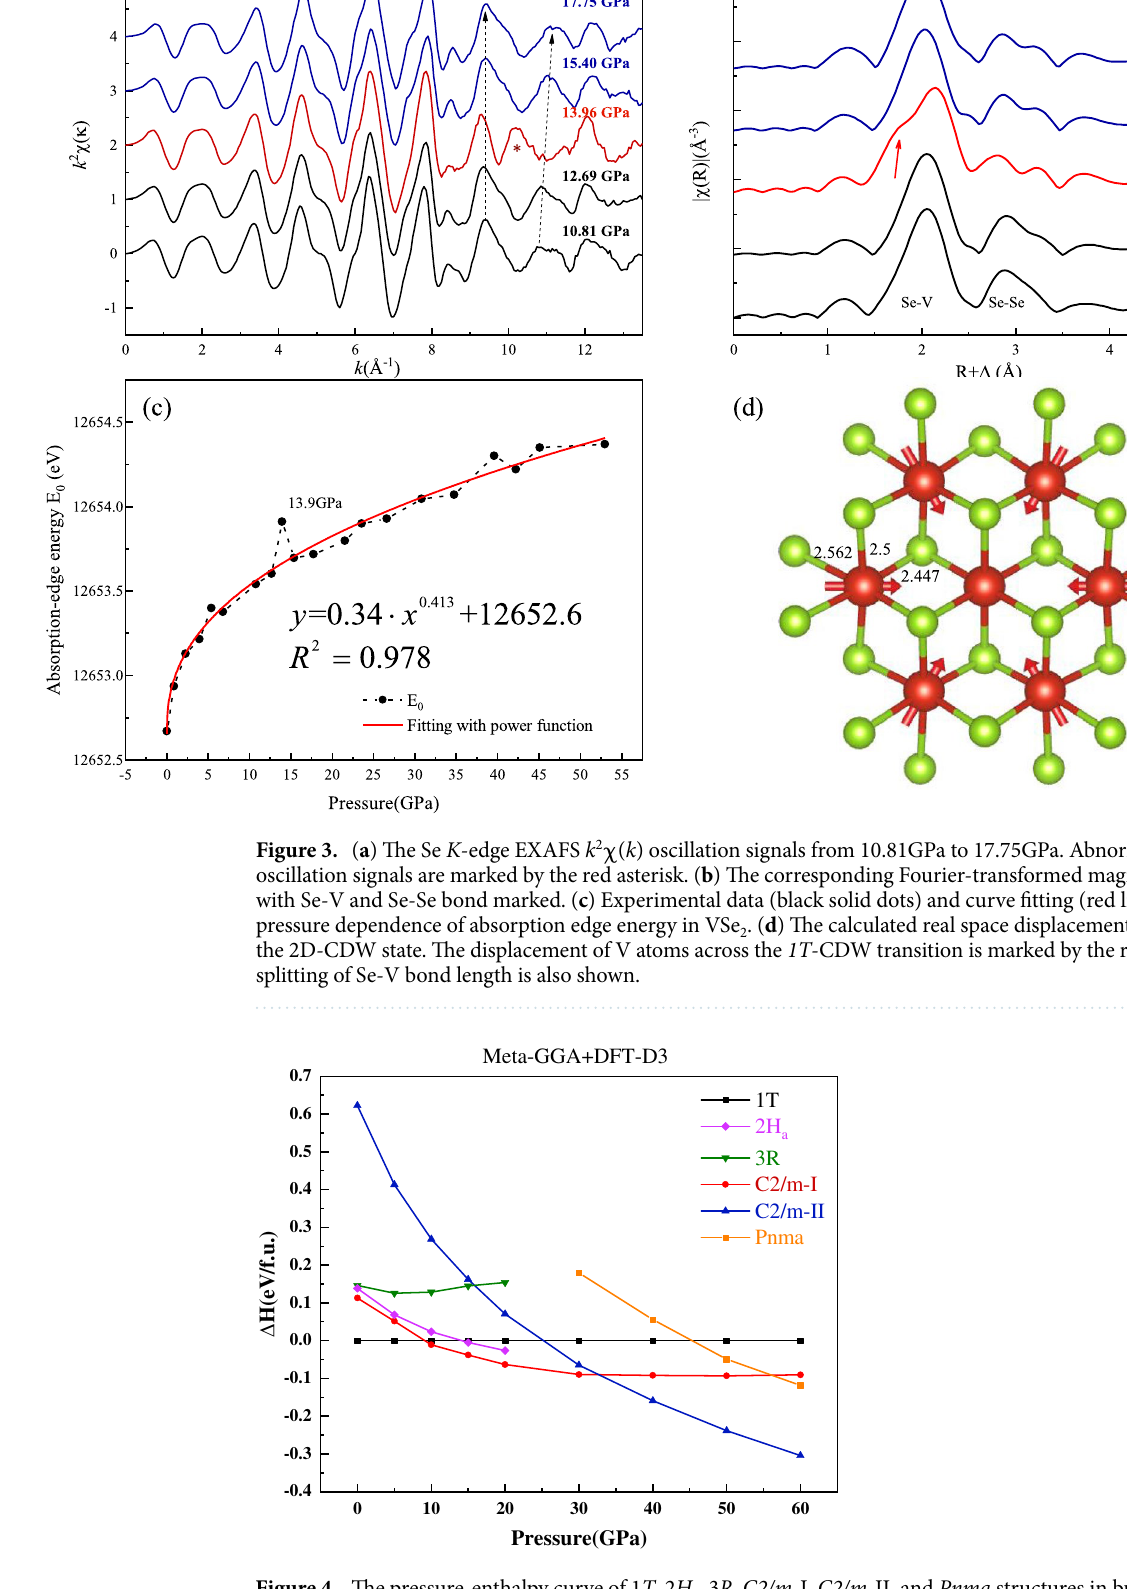
Figure 4. The pressure-enthalpy curve of 1 T , 2 H a , 3 R , C2/m -I, C2/m -II, and Pnma structures in bulk VSe 2 . The 1 T -FM state was used as a reference ground state. The calculation in this figure is based on the Meta-GGA exchange–correlation potential with van der Waals (vdW) interactions considered in the DFT-D3